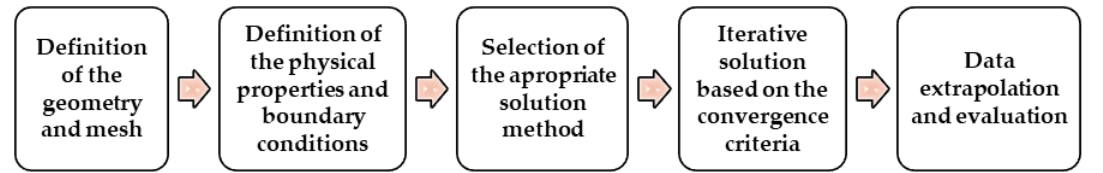
Figure 1. Main steps performed in numerical simulations.